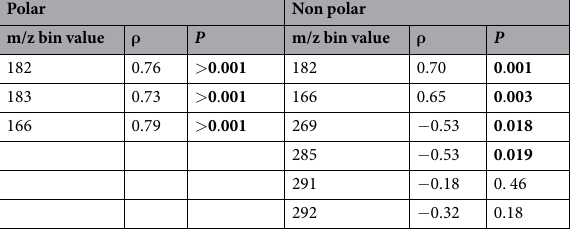
Table 1. Mass/charge (m/z) bins from polar and non-polar samples identified by RF models. The relationships between abundance (% TIC per bin) and the LD1 discrimination profile were tested with Spearman’s rank correlation (S). DF =